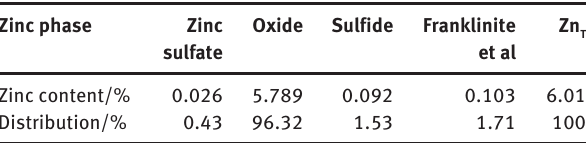
Table 2: Mineralogical analysis of zinc-containing phases (mass